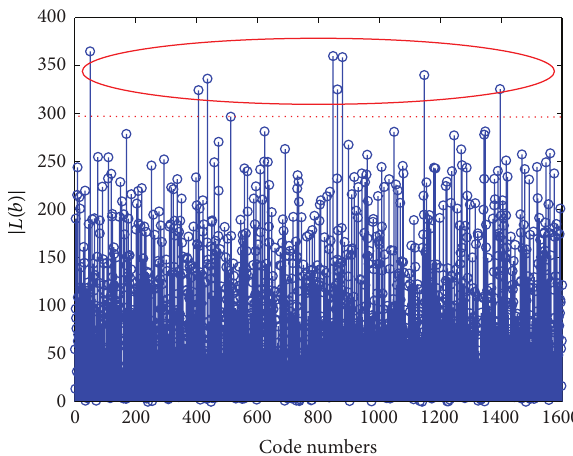
Figure 1: Relationship between code numbers and mapping func- tion |𝐿( b )|